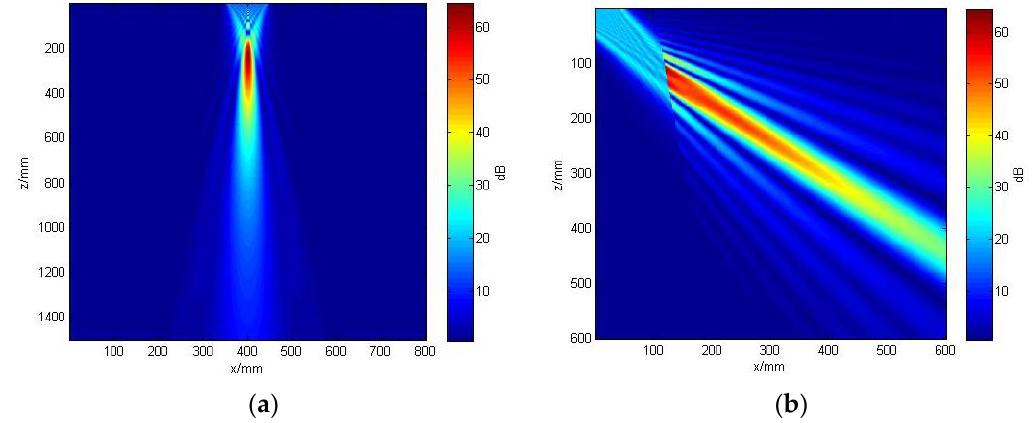
Figure 7. The acoustic field: ( a ) acoustic field of the probe in water; ( b ) acoustic field of the probe with a tapered wedge in the circular tube material in the condition of a convex cylindrical interface. There are two factors a ff ecting the beam steering and focusing behaviors: one is the surface curvature of the circular tube material, the other is caused by the length and the width of the element. The e ff ect of the surface curvature of the circular tube is discussed